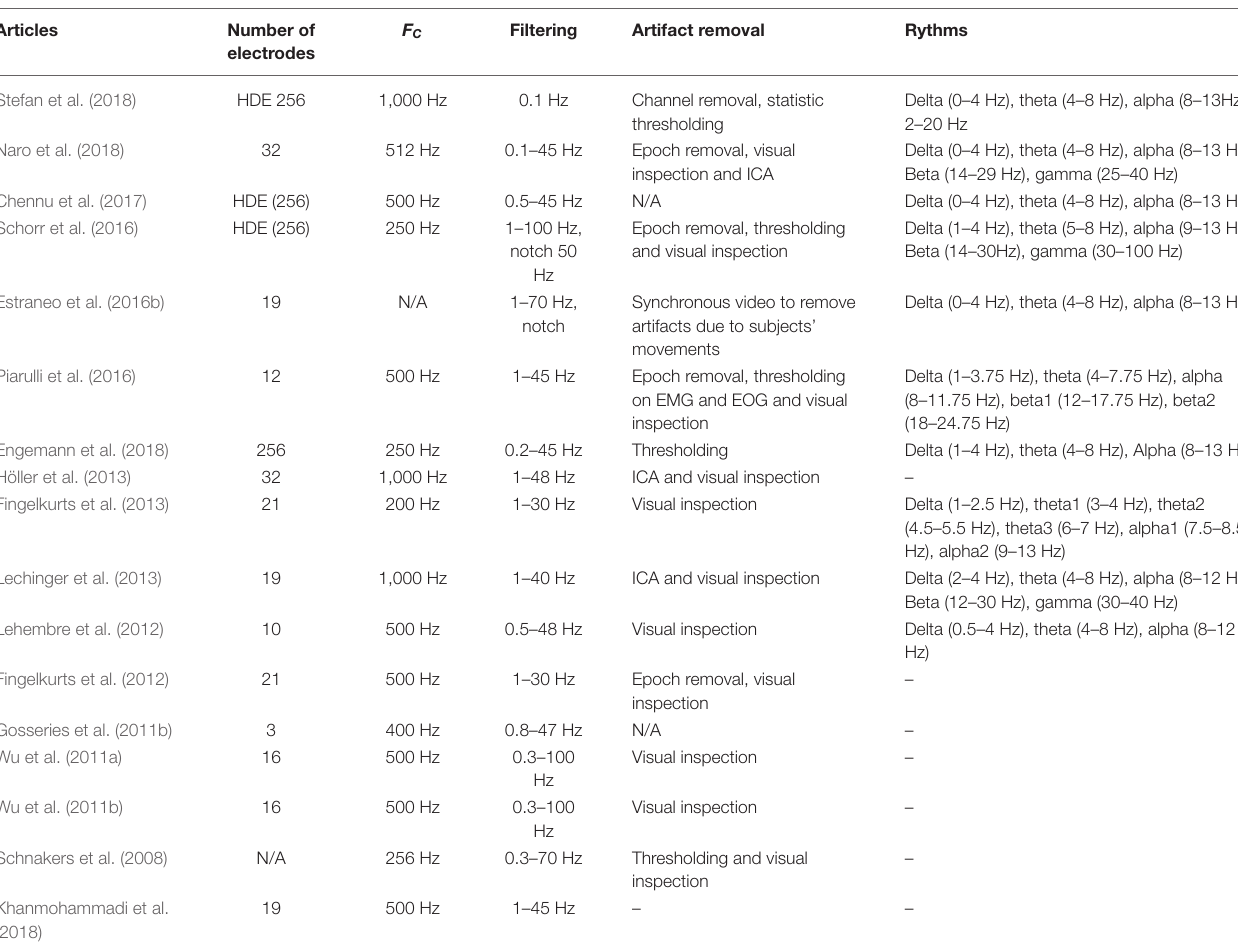
TABLE 2 | Acquisition and